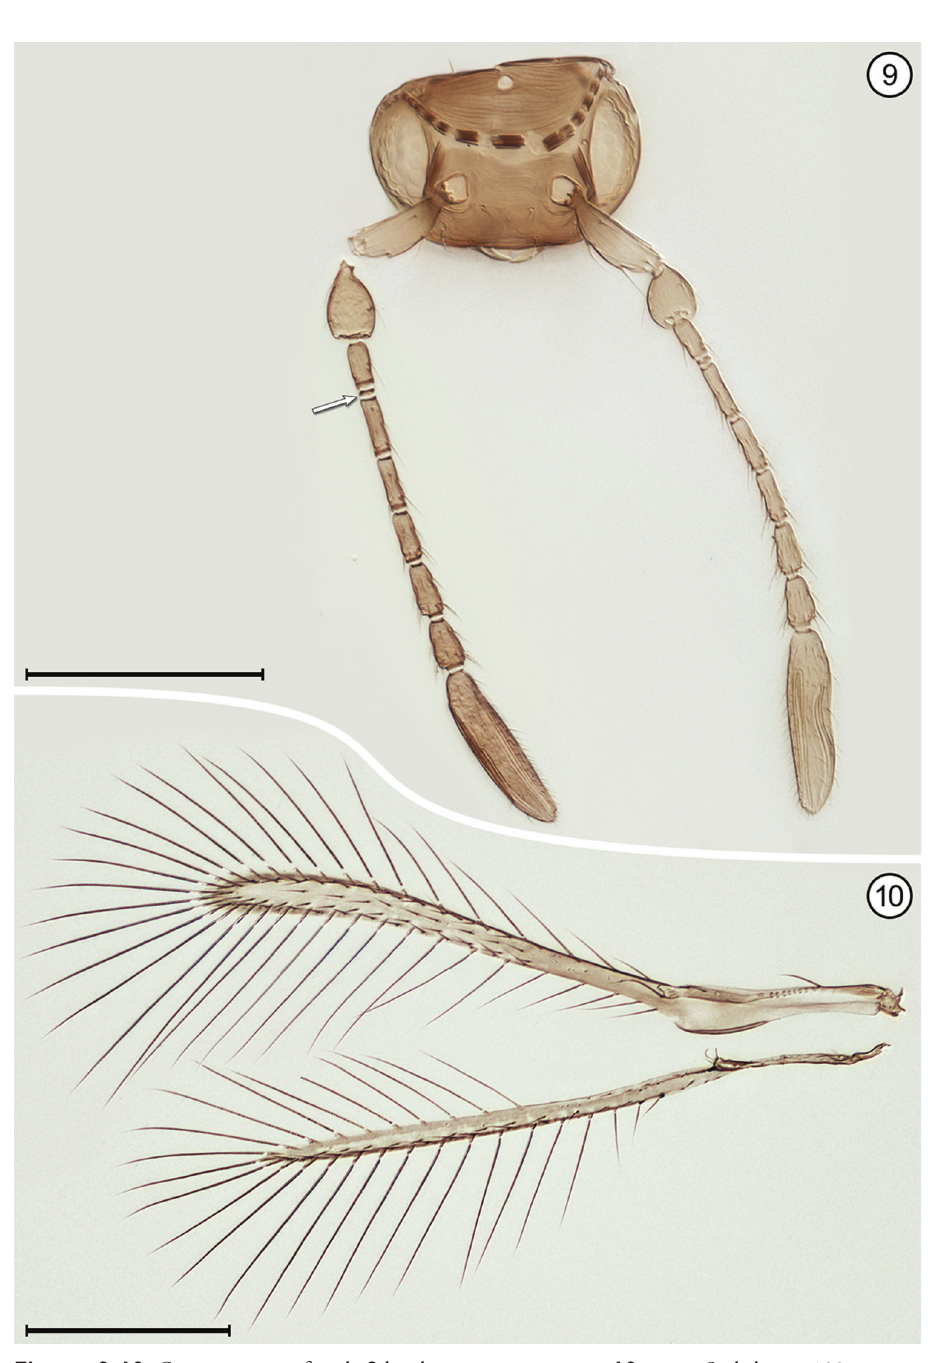
Figures 9, 10. Camptoptera sp., female 9 head, anterior + antennae 10 wings. Scale bars = 100